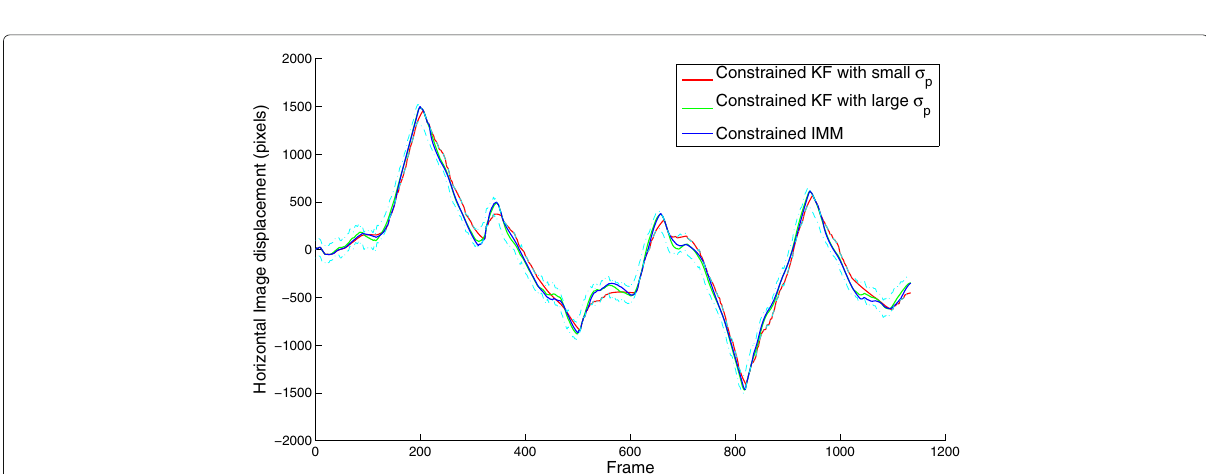
Fig. 7 Video 1 horizontal motion: comparison between single-model constrained Kalman filtering and constrained IMM. Cyancurves are constraint boundaries